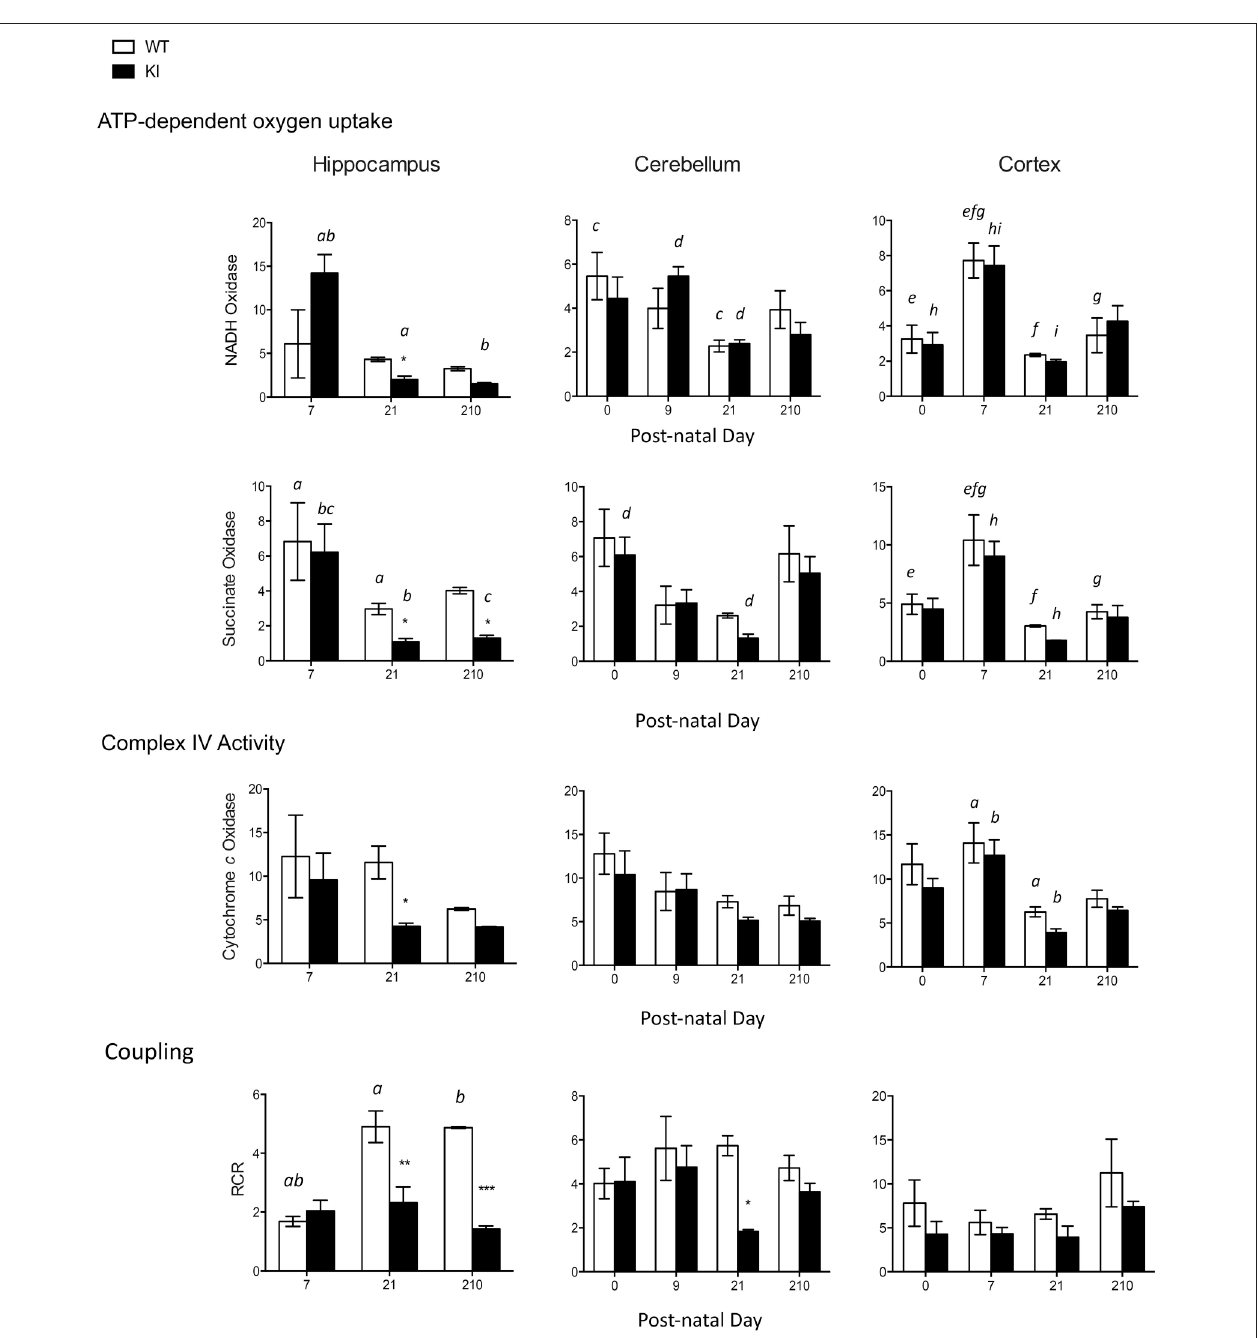
FIGURE 2 | Brain bioenergetics of KI mice during neurodevelopment and adulthood. Mitochondria were isolated from cortex, cerebellum, and hippocampus of WT and KI pups as described in the Methods section. Activities of NADH oxidase, succinate oxidase, and cytochrome c oxidase (CCO), and respiratory control ratio (RCR) were evaluated at PND0 (cerebellum and cortex only, due to the scarcity of hippocampal tissue), PND7, PND21, and PND210. Data are reported as mean ± SEM, n = 3–7 per genotype per time point. Statistical analysis was performed by Two-way ANOVA. Post-hoc analysis performed by Tukey’s HSD test revealed significant differences between WT and KI indicated by asterisks as follows NADH oxidase: * p = 0.0468; Succinate oxidase: * p = 0.0466 at PND21, * p = 0.0423 at PND210; Cytochrome c oxidase: * p = 0.0484; Coupling: ** p = 0.001, *** p = 0.0004, * p = 0.0496. Letters indicate statistically significant differences amongst time points as follows. NADH oxidase: p = 0.0291 ( a ), p = 0.0033 ( b ), p = 0.0166 ( c ), p = 0.0320 ( d ), p = 0.0036 ( e ), p = 0.0001 ( f ), p = 0.0113 ( g ), p = 0.0032 ( h ), p = 0.0004 ( i ); Succinate oxidase: p < 0.0001 ( a ), p = 0.0002 ( b ), p = 0.0240 ( c ), p = 0.0434 ( d ), p = 0.0283 ( e ), p = 0.0009 ( f ), p = 0.0250 ( g ), p = 0.0013 ( h ); Cytochrome c oxidase: p = 0.0053 ( a ), p = 0.0035 ( b ). Coupling: p = 0.0003 ( a ), p = 0.0010 ( b ). Further statistical details on the genotype, age, and genotype × age effect can be found in the legend of Table 3 .